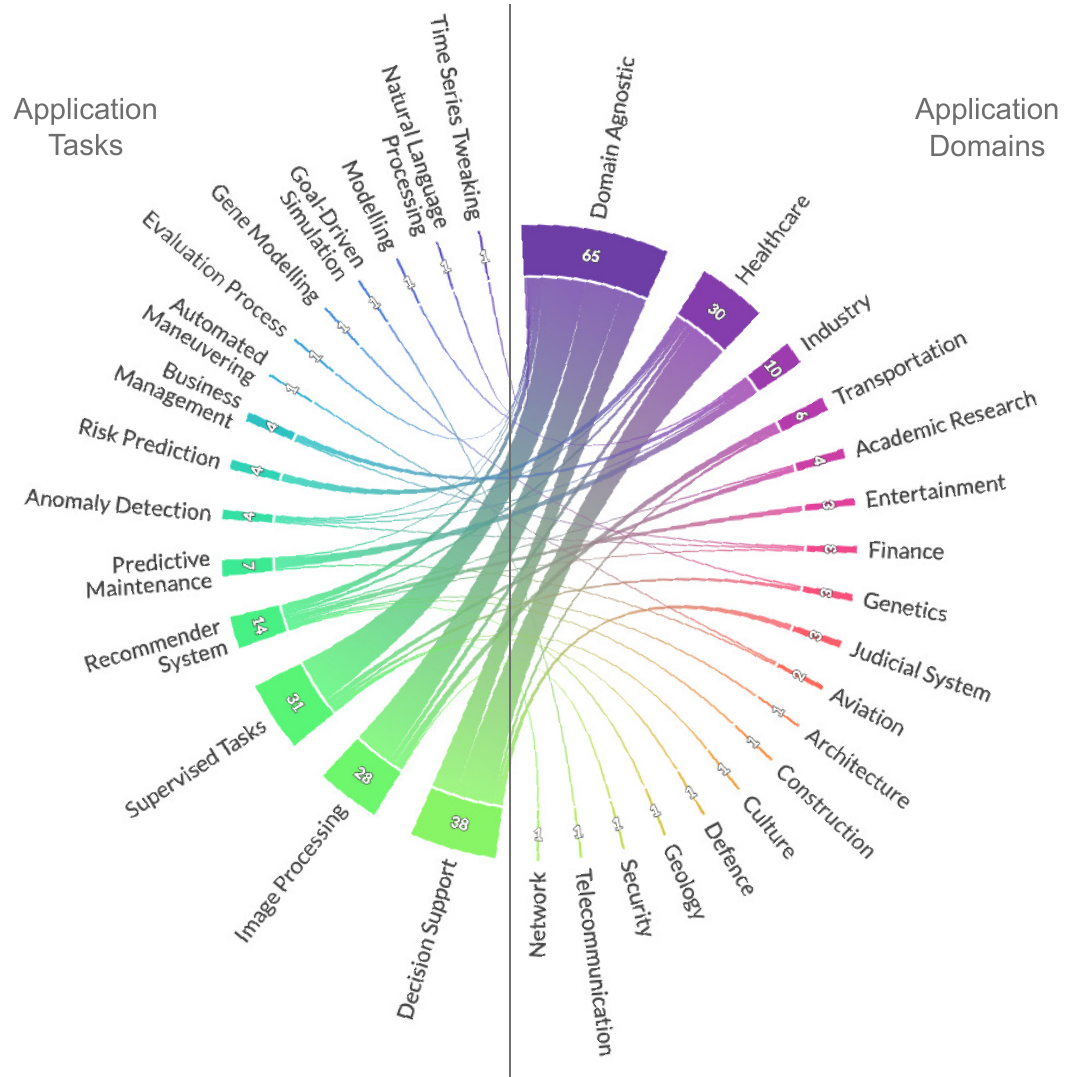
Figure 8. Chord diagram [45] presenting the number of selected articles published on the XAI methods and evaluation metrics from different application domains for the corresponding